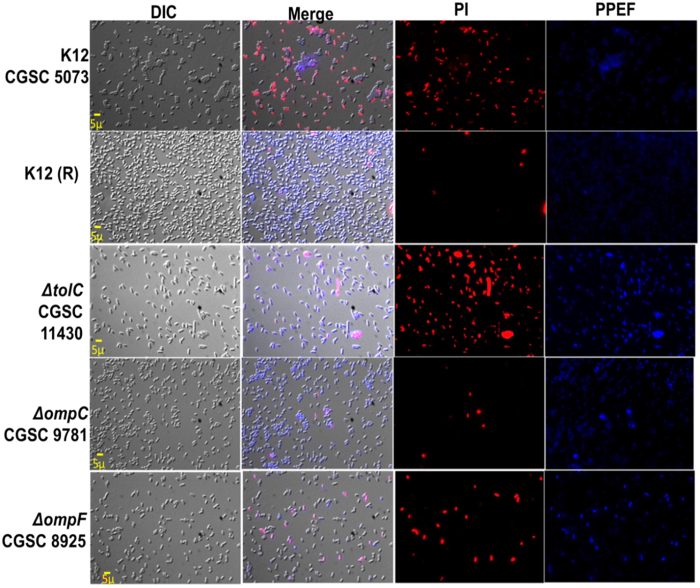
Analysis of PPEF uptake and PI staining using Zeiss microscope.Representative images of E. coli K12 and E. coli K12 derived (ΔtolC, ΔompC and ΔompF) mutants detected at emission wavelength range 450–500 nm for compound PPEF signal, 610–750 nm for PI signal and merged images are shown. Bacteria exhibiting blue fluorescence indicate PPEF uptake and red or purple fluorescence indicate damaged membrane and are considered as dead cells.